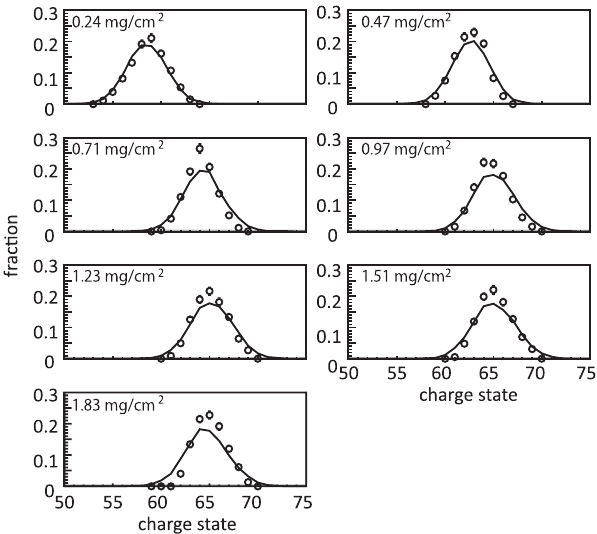
FIG. 8. Fitting results for the charge-state distribution in He gas strippers of various thicknesses. Solid lines indicate calcu- lated probabilities, F cal (cid:4) ð q i Þ